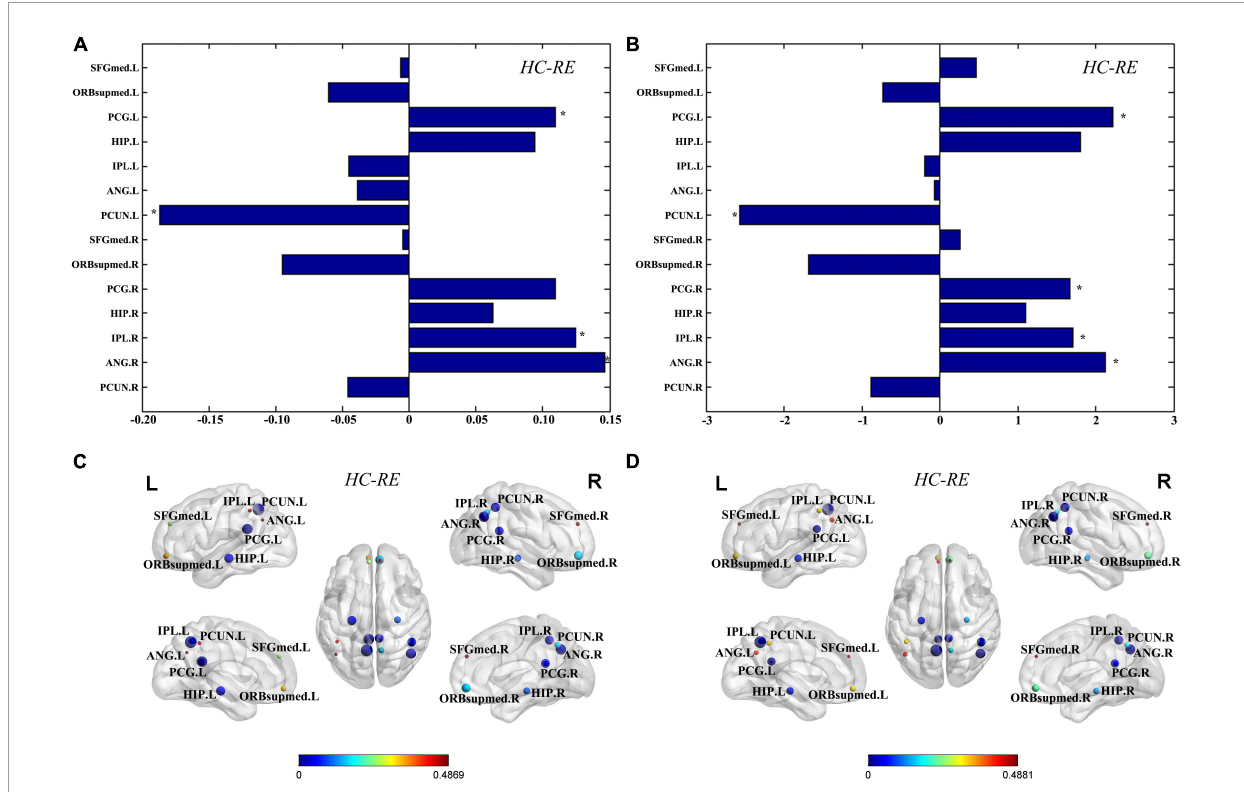
FIGURE2 Regional graph theoretic measures. Differences of nodal efficiency (A) and degree centrality (B) for each node were evaluated between the TLE and HC group. The differences of nodes in nodal efficiency (C) and degree centrality (D) between the TLE and HC groups were displayed in the MNI space. The size of nodes represents difference between the TLE and HC groups, and the color of nodes and the color bar represent statistical significance. *Statistically significant (q < 0.05, FDR corrected). SFGmed, superior frontal gyrus, medial; ORBsupmed, superior frontal gyrus, medial orbital; PCG, posterior cingulate gyrus; HIP, inferior parietal gyrus; IPL, inferior parietal gyrus; ANG, angular gyrus; PCUN, precuneus; L, left; R, right.